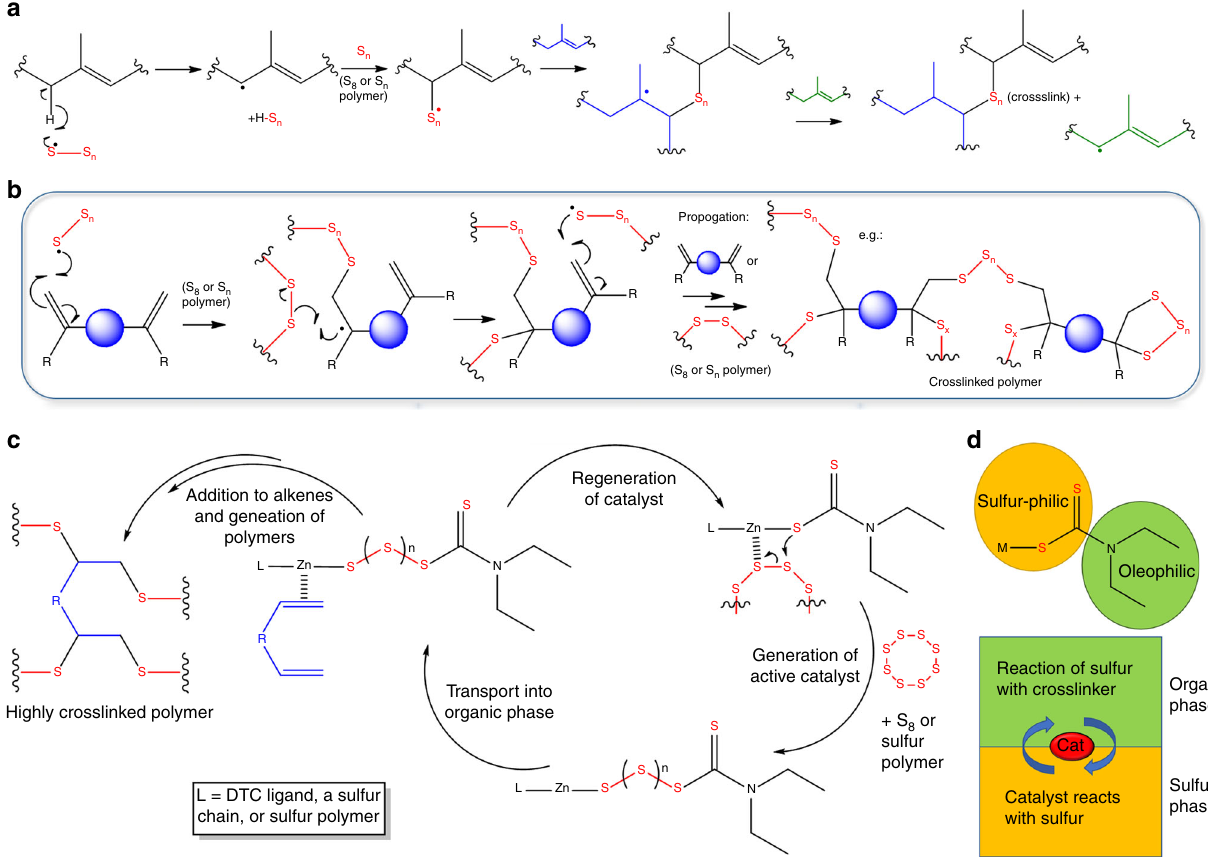
Fig. 4 Reaction schemes of vulcanizations. a Reaction scheme of conventional vulcanization. b Reaction scheme for inverse vulcanization (chain transfer, branching, and termination omitted). c Suggested catalytic cycle for inverse vulcanization. d Representation of the catalyst as a phase transfer agent